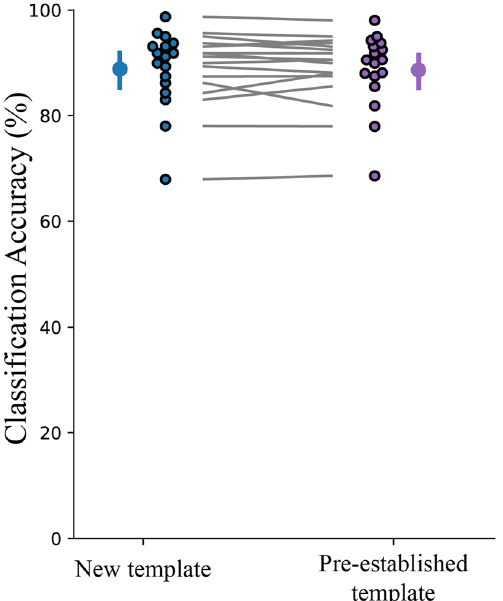
Figure 6. Decoding effects of using all participants to create a template space versus hyperaligning a new participant to a pre-established template. Individual participants are presented beside the mean as circles with a black outline. Error bars indicate a 95% confidence interval.